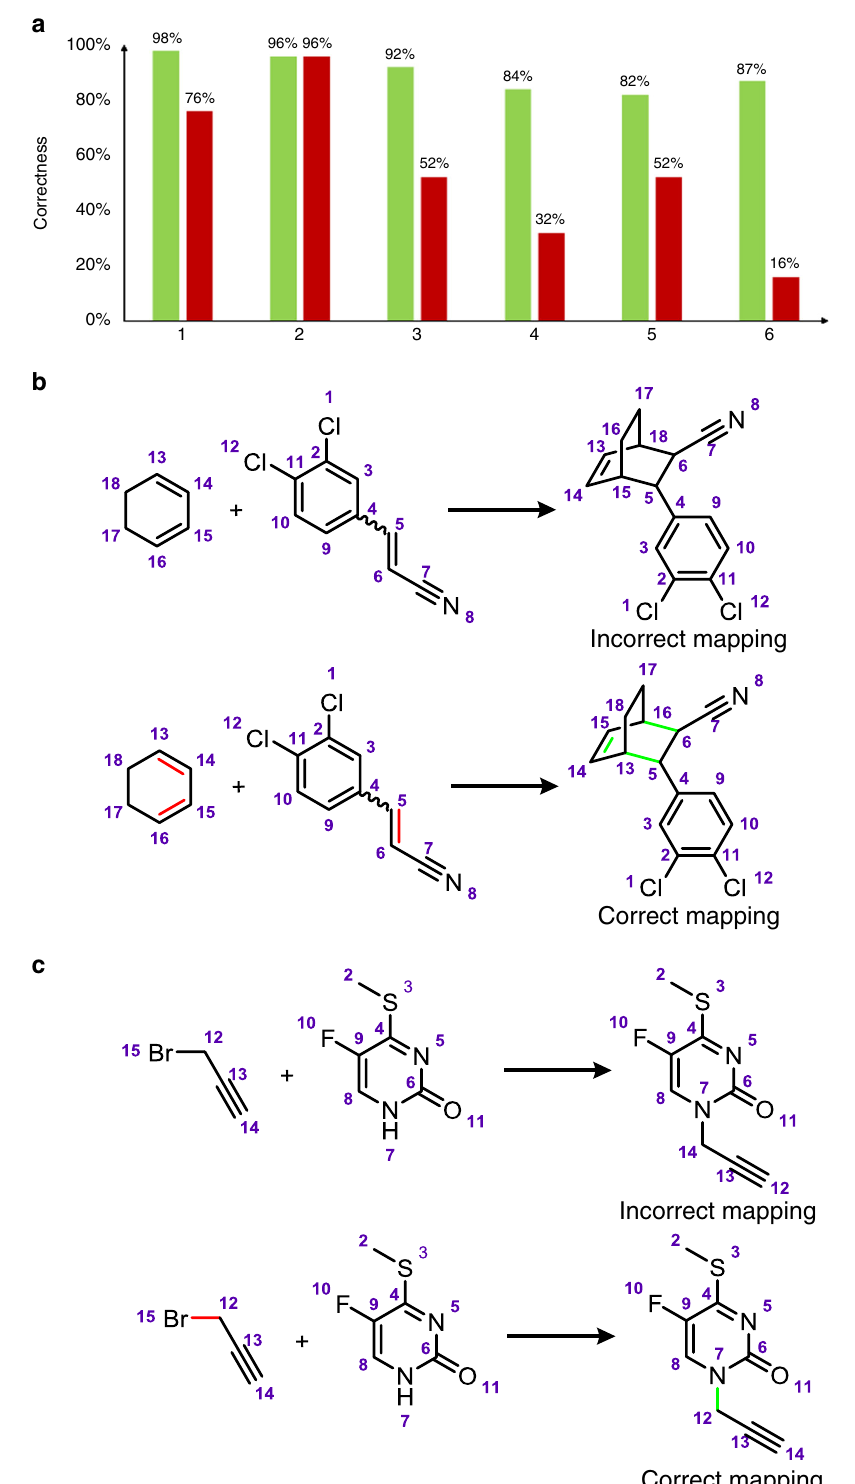
Fig. 7 Comparison of our algorithm against USPTO mappings. a Percentages of correct USPTO mappings (red bars) and those by our algorithm (green bars) categorized according to the number of bonds broken/created, from one to six. Statistics are based on 50 reactions each for one to fi ve bonds being changed and 31 reactions for six bonds. We note that in addition to chemically meaningful reactions for which we compared the mappings, the USPTO set also contained a large fraction of nonsensical reactions that were likely due to human entry errors in the databases they used (e.g., missing key reaction partners, creating atoms “ ex nihilo ” , etc., see Supplementary Fig. 9). Such reactions as well as simple deprotections were not included in the